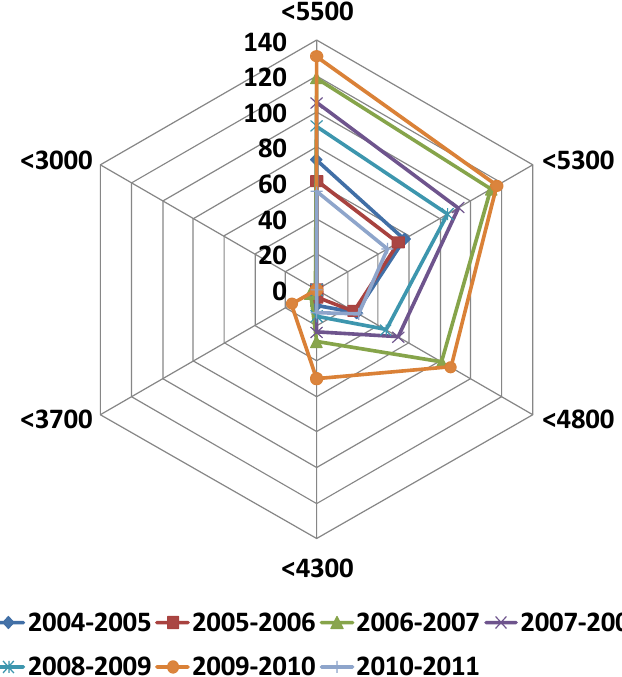
Figure 3. Number of days with inflow less than threshold values during dry seasons between 2004 and 2010 (m 3